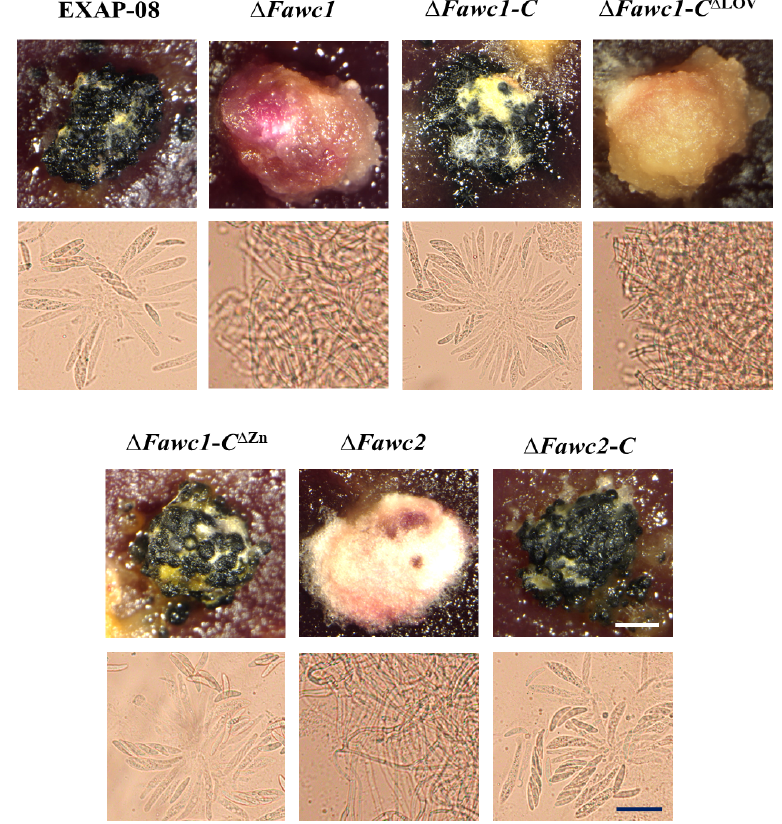
Figure 5. Regulation of Fawc1 and Fawc2 on the sexual reproduction development processes of F. asiaticum . The perithecium formed by each strain on carrot agar medium was observed via stereomicroscope. Via picking up the perithecia and pressing them on glass slides for microscopic analysis, mature ascospores were observed from the perithecia of EXAP-08, ∆ Fawc1-C , ∆ Fawc1-C ∆ ZnF , and ∆ Fawc2-C strains, while in contrast, only mycelium biomass could be found in the immature perithecium of ∆ Fawc1 , ∆ Fawc2 , and ∆ Fawc1-C ∆ LOV mutant strains.